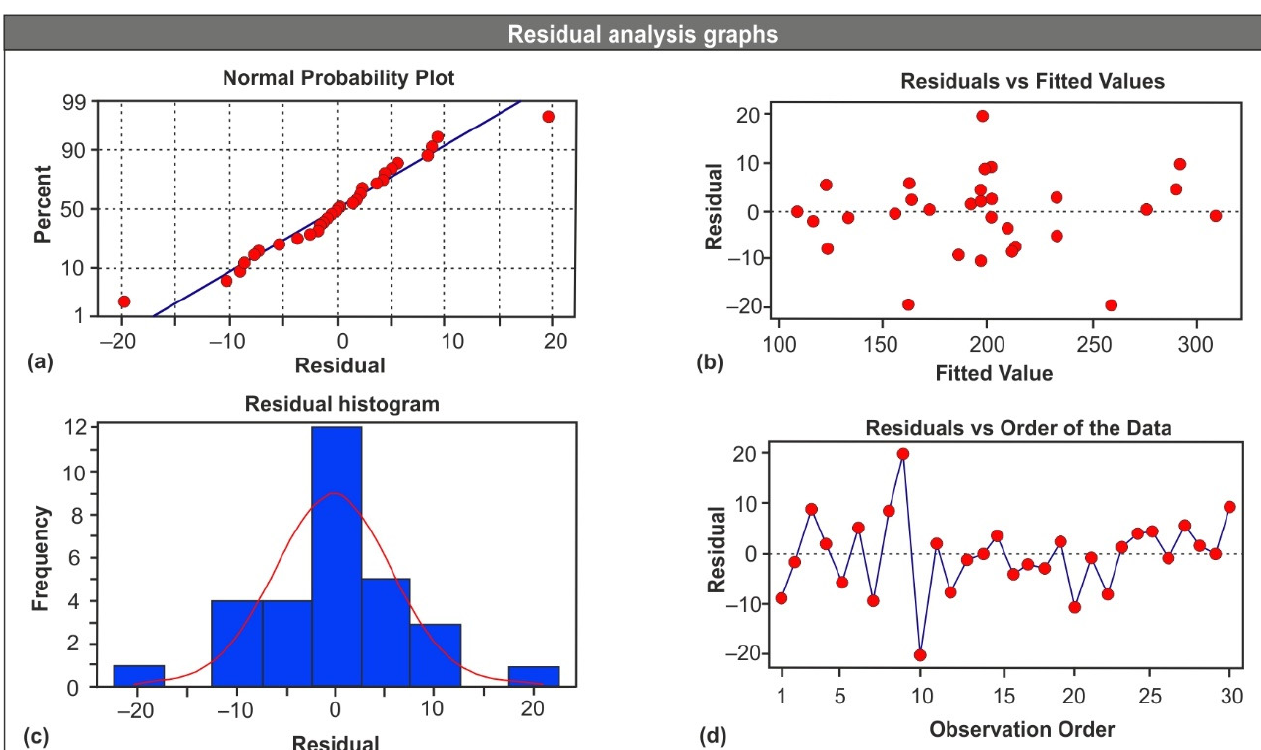
Figure 6. Residual analysis graphs: ( a ) probability plot, ( b ) residuals versus fitted values, ( c ) residual histogram and ( d ) residuals versus order.